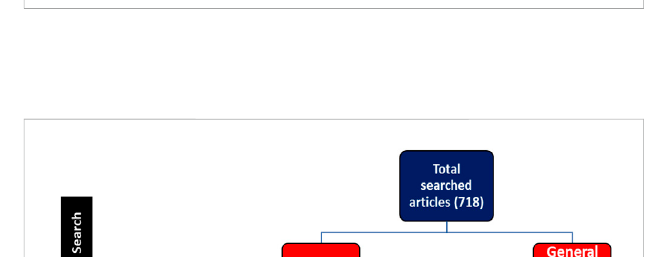
FIGURE 2 Framework of data and methodology.